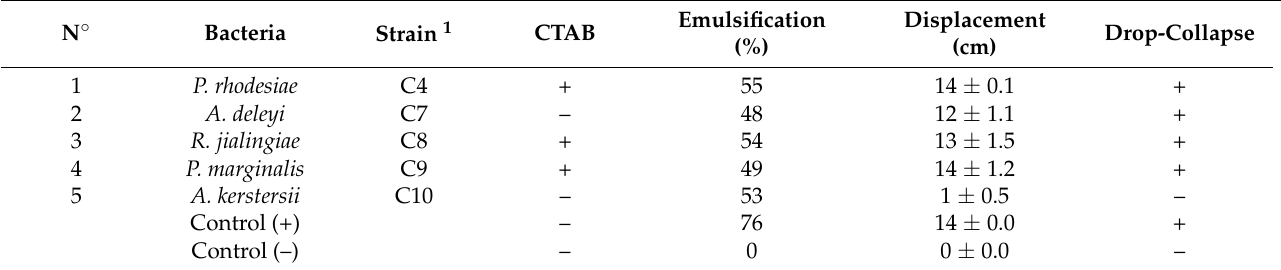
Table 1. Pesticide-tolerant bacterial strains tested as potential producers of biosurfactants in Siegmund and Wagner (SW) agar and Bushnell-Haas (BH) media.